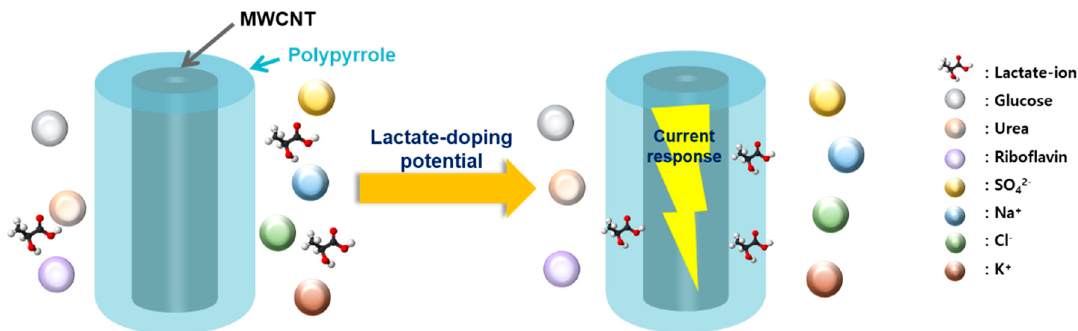
Figure 1. Schematic illustration for selective detection of lactic acid without interference of neutral and cationic species.